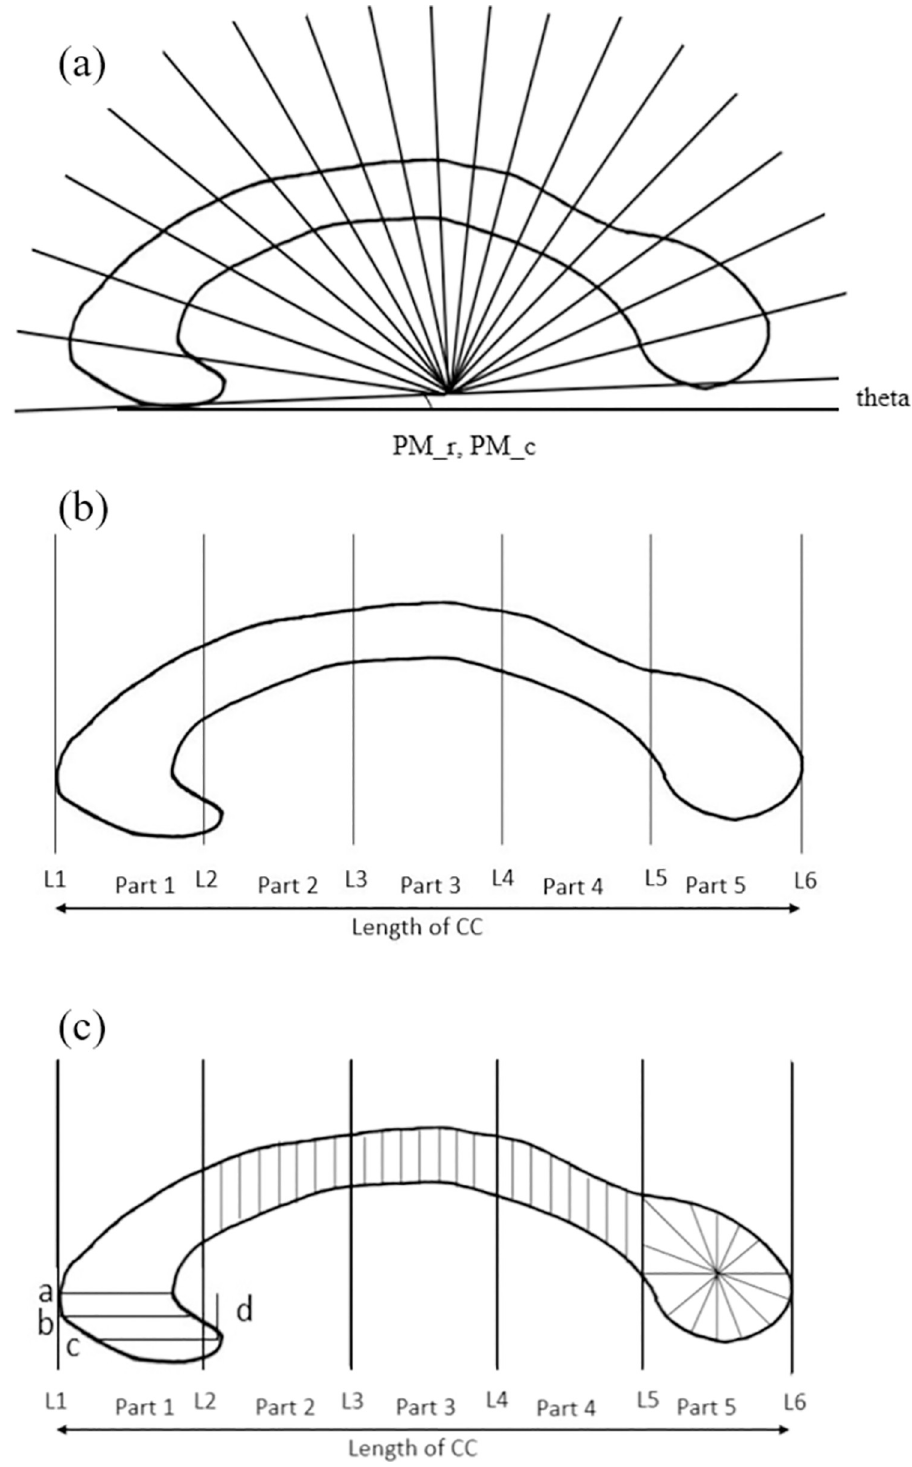
Fig 1. Estimation of MRI measurements (a) Evaluation of total CC length (b) Division of CC in five subregions (c) Measurements of each subregion (a, the width of the genu; b, the width of center between genu and rostrum; c, the width of rostrum; and d, height between the width of genu and rostrum; vertical lines of part 2, 3, 4; the height of the anterior, middle, and posterior body portion; lines of part 5, the rotatory diameter of region 5).